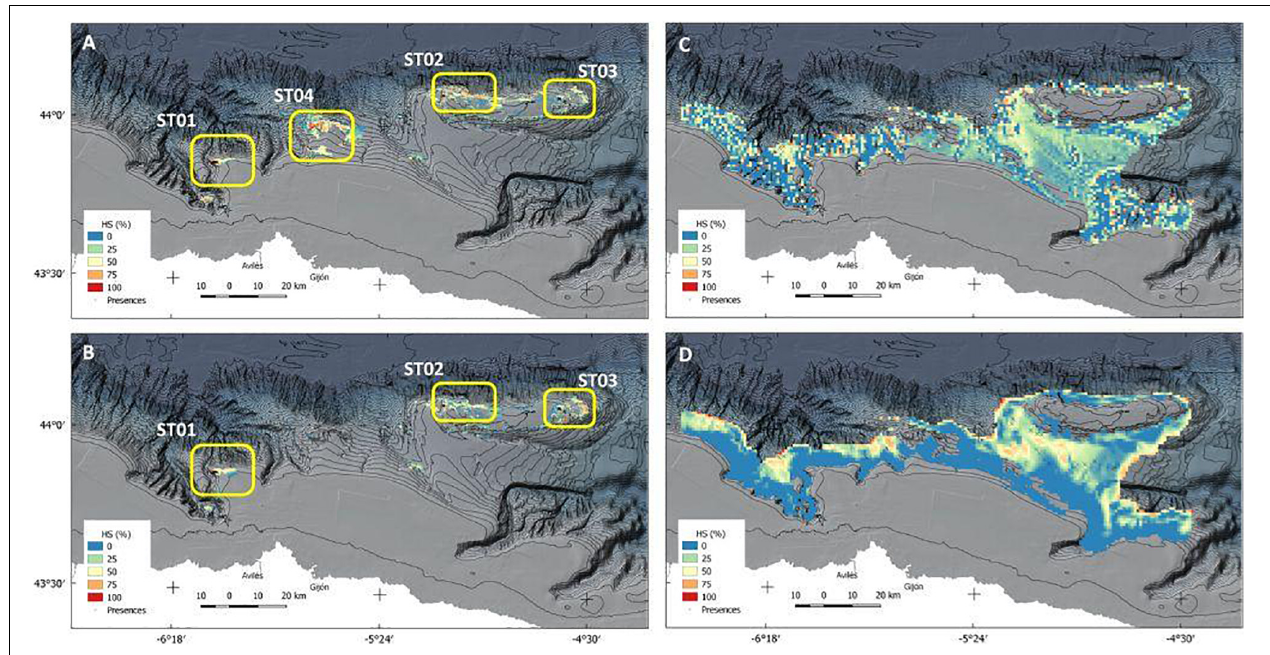
FIGURE 7 | Habitat suitability (HS) predictive maps for each of the species: part labels (A,B) corresponds to A. setubalense models 1 and 2, and (C,D) to the P. carpenteri Models 1 and 2 respectively. Model 1 has been constructed only with geomorphologic predictors, and model 2 includes physicochemical predictors for both